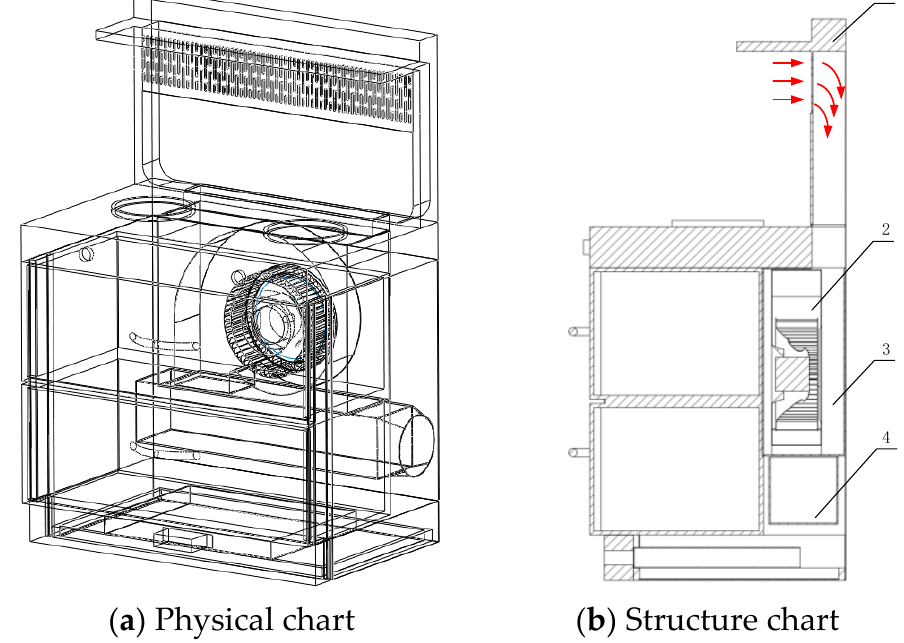
Figure 2. Structure diagram of integrated cooker smoke exhaust system.